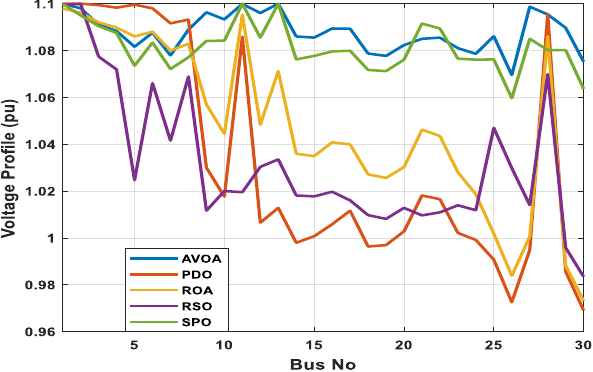
Figure 10. The AVOA voltage profile with the other compared methods for case 4.